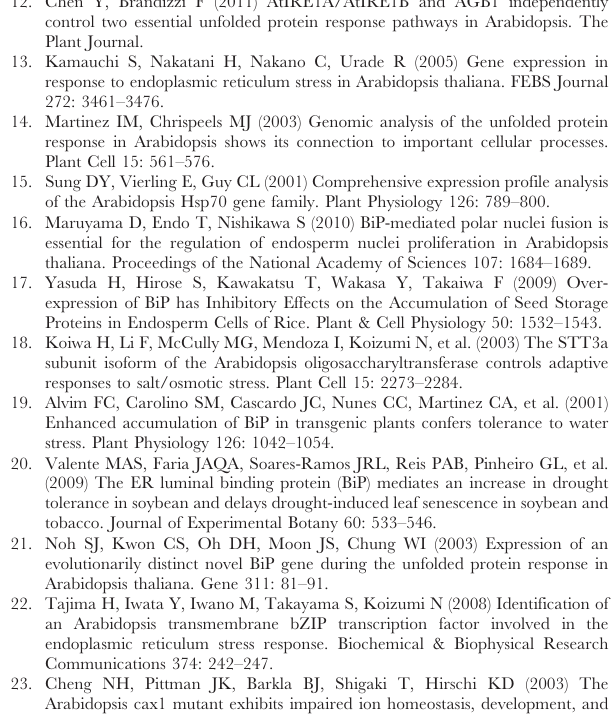
Figure S2 Effect of DTT on root growth and germina- tion. Germination rates and root lengths were measured in WT seedlings 1, 3 and 6 d after sowing on DTT-supplemented MS medium. Error bars = SE. Figure S3 Phenotypes of transgenic and mutant lines. A. WT, bzip60 mutant and transgenic lines grown for 7 days on MS medium and over-expressing bZIP60 full-length or spliced variants in WT and bzip60 backgrounds. B. ire1a mutant and IRE1b RNAi lines in WT and ire1a backgrounds. One representative line is shown for each transformed